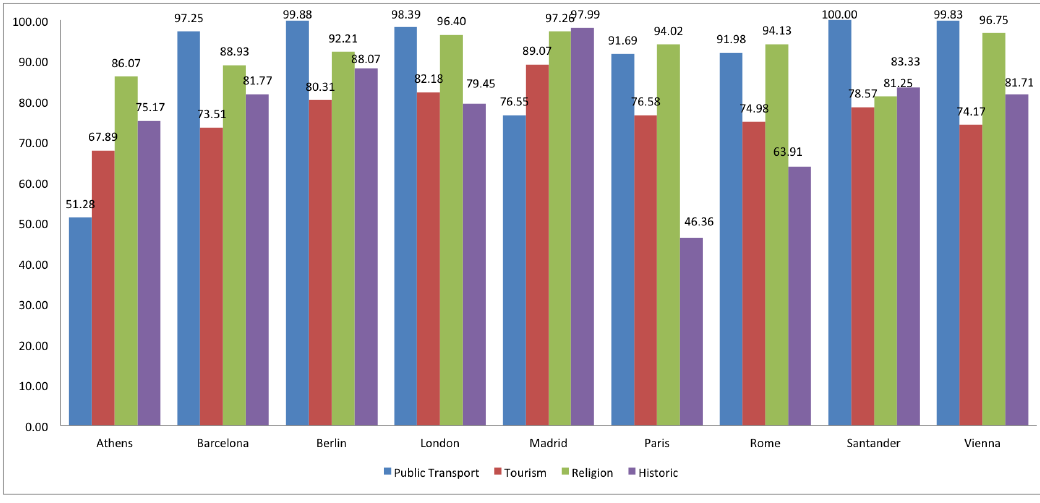
Figure 21. Completeness study in Europe. Percentage of name in public transport, tourism, religion and historic